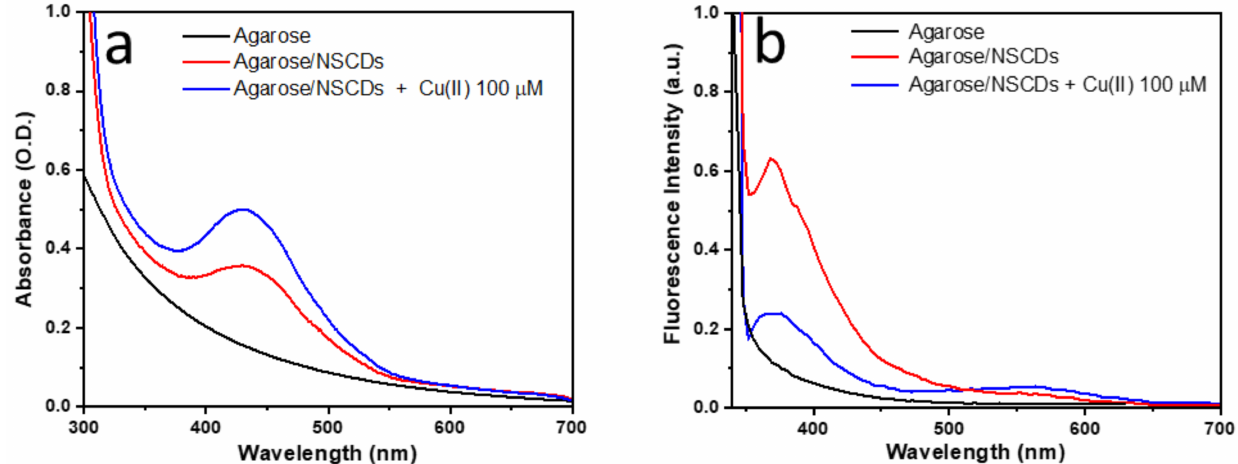
Figure 8. ( a ) UV-vis absorption and ( b ) fluorescence emission spectra of hydrogel Aga-NSCD films after immersion in DI water with a Cu(II) concentration of 100 µ M. Emission spectra were acquired with l exc = 320 nm.